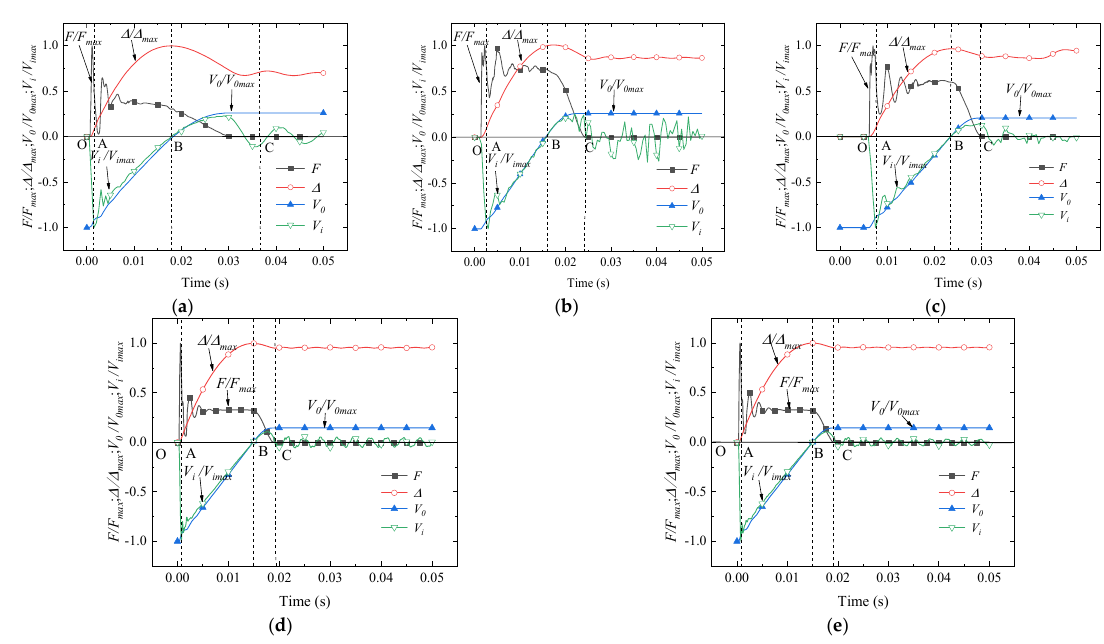
Figure 8. Normalized time history curve. ( a ) RC; ( b ) H-DS; ( c ) S-DS; ( d ) S-ST; ( e ) R-ST.